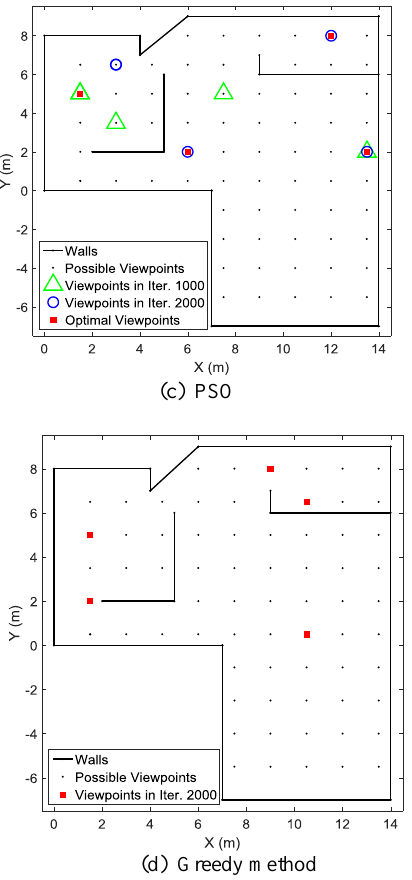
Figure 9. Layout of optimal viewpoints from different methods